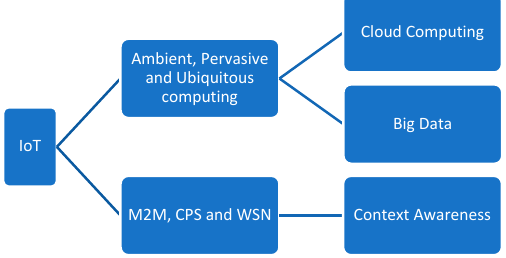
Figure 2. Relationship of the IoT and related technologies.